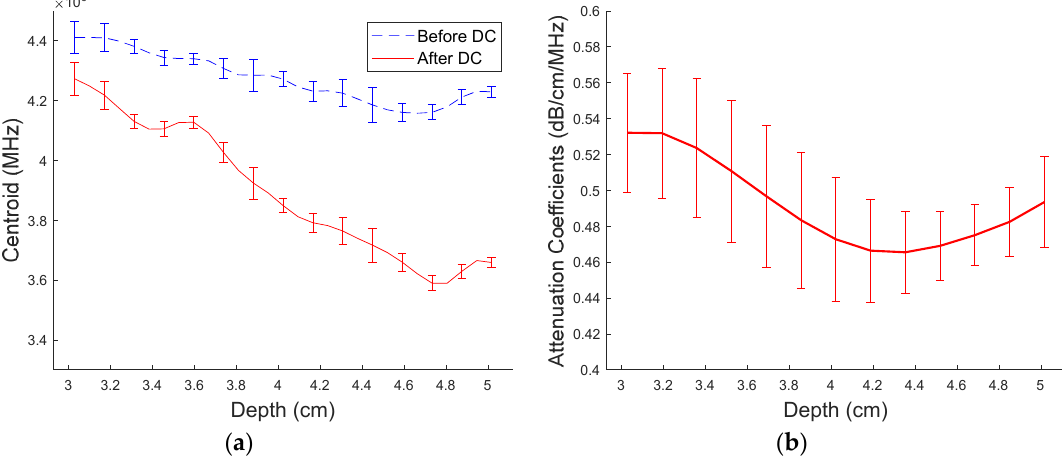
Figure 8. Results of spectral analysis of signal propagation through the m12 phantom: ( a ) Estimated variation of centroid with depth before (blue dotted line), and after (red solid line) DC. ( b ) Estimated attenuation coefficients. Table 2. Normalized RMSE of attenuation coe ffi cient